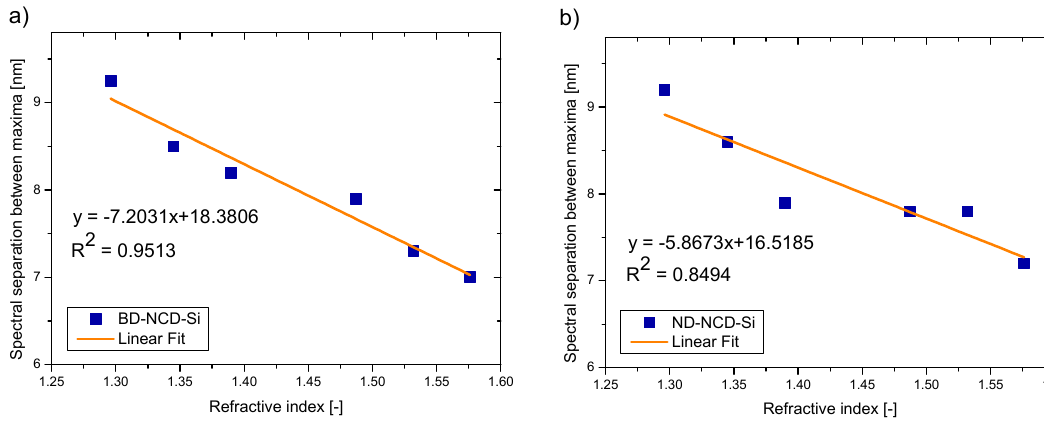
Figure 8. Measurement results: spectral separation between maxima as a function of refractive index for wavelength equal to 1560 nm ( a ) BD-NCD-Si, ( b ) ND-NCD-Si. The values of correlation coefficient R 2 and sensitivity S for each sensor working at central wavelength of 1560 nm are calculated and presented in Table 3. Table 3. Correlation coefficient (R 2 ) and sensitivity (S) values for sensors working at 1560 nm. Parameters BD-NCD-Si